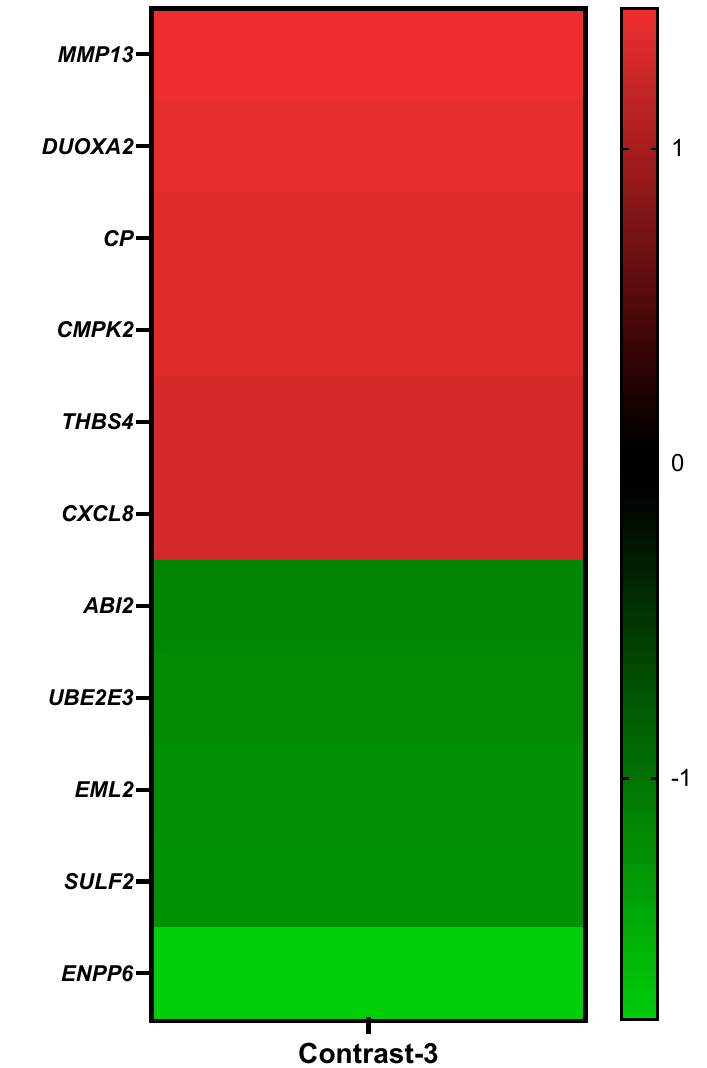
Figure 4. A heat map depicting the color-coded expression levels (log-ratio M values) of the top six upregulated and five downregulated DEGs in the LPS treated IBD colonoids vs. the control IBD colonoids (Contrast-3). The log-ratio M values represent the log(R/G) (log fold change) [44]. The detailed information on genes is presented in Table 6.